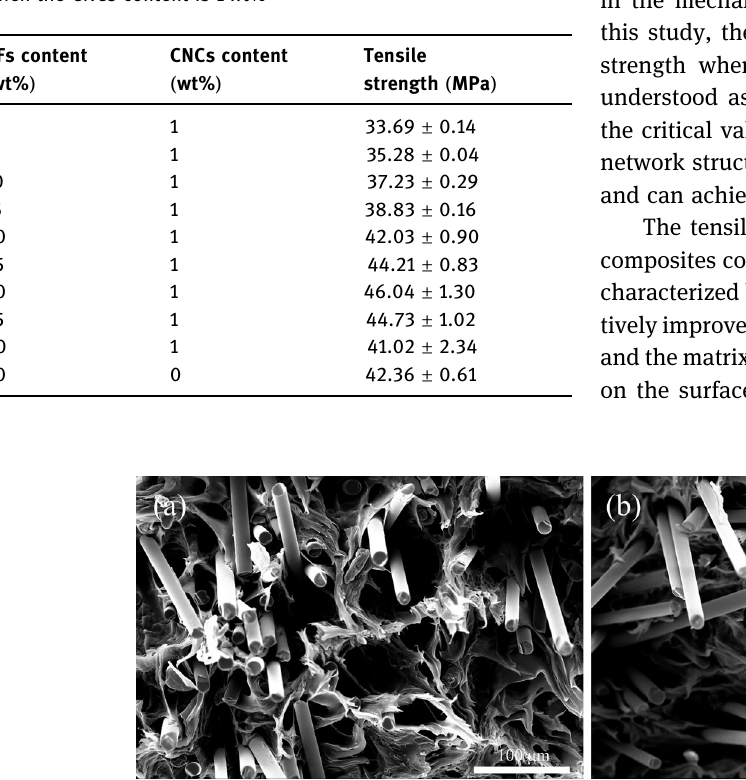
Table 3: Tensile strength of composites with di ff erent BFs content when the CNCs content is 1 wt%